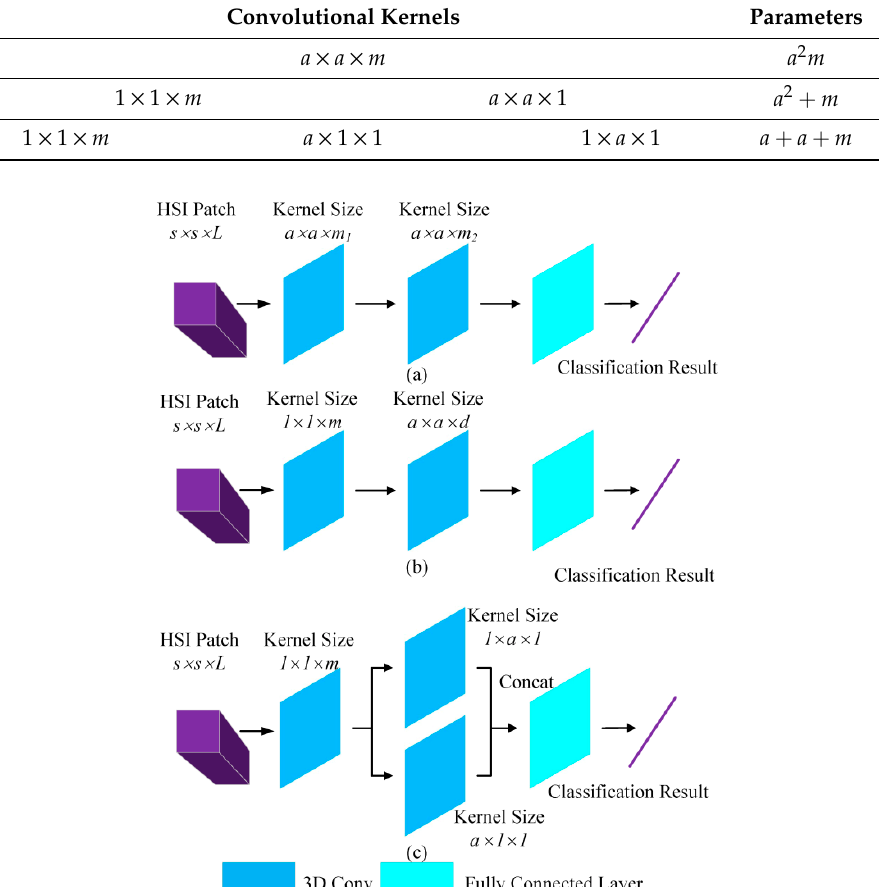
Table 1. Parameters for di ff erent convolutional kernels.